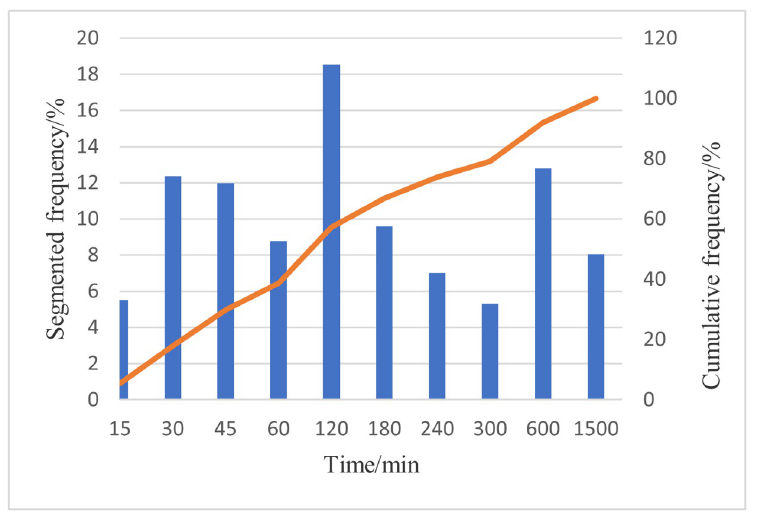
Fig 2. Time of spatial accessibility of beautiful leisure